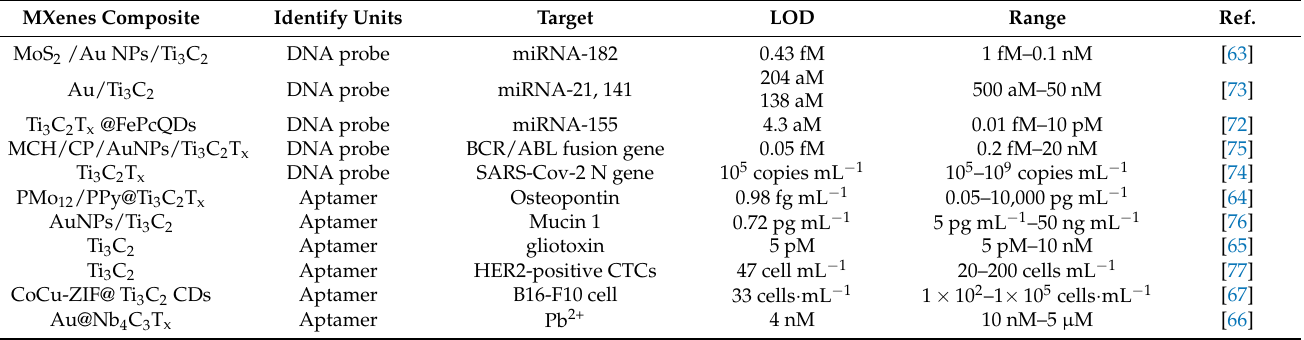
Table 2. Nucleic acid-based electrochemical biosensors identify units, target, and analytical parameters. MXenes